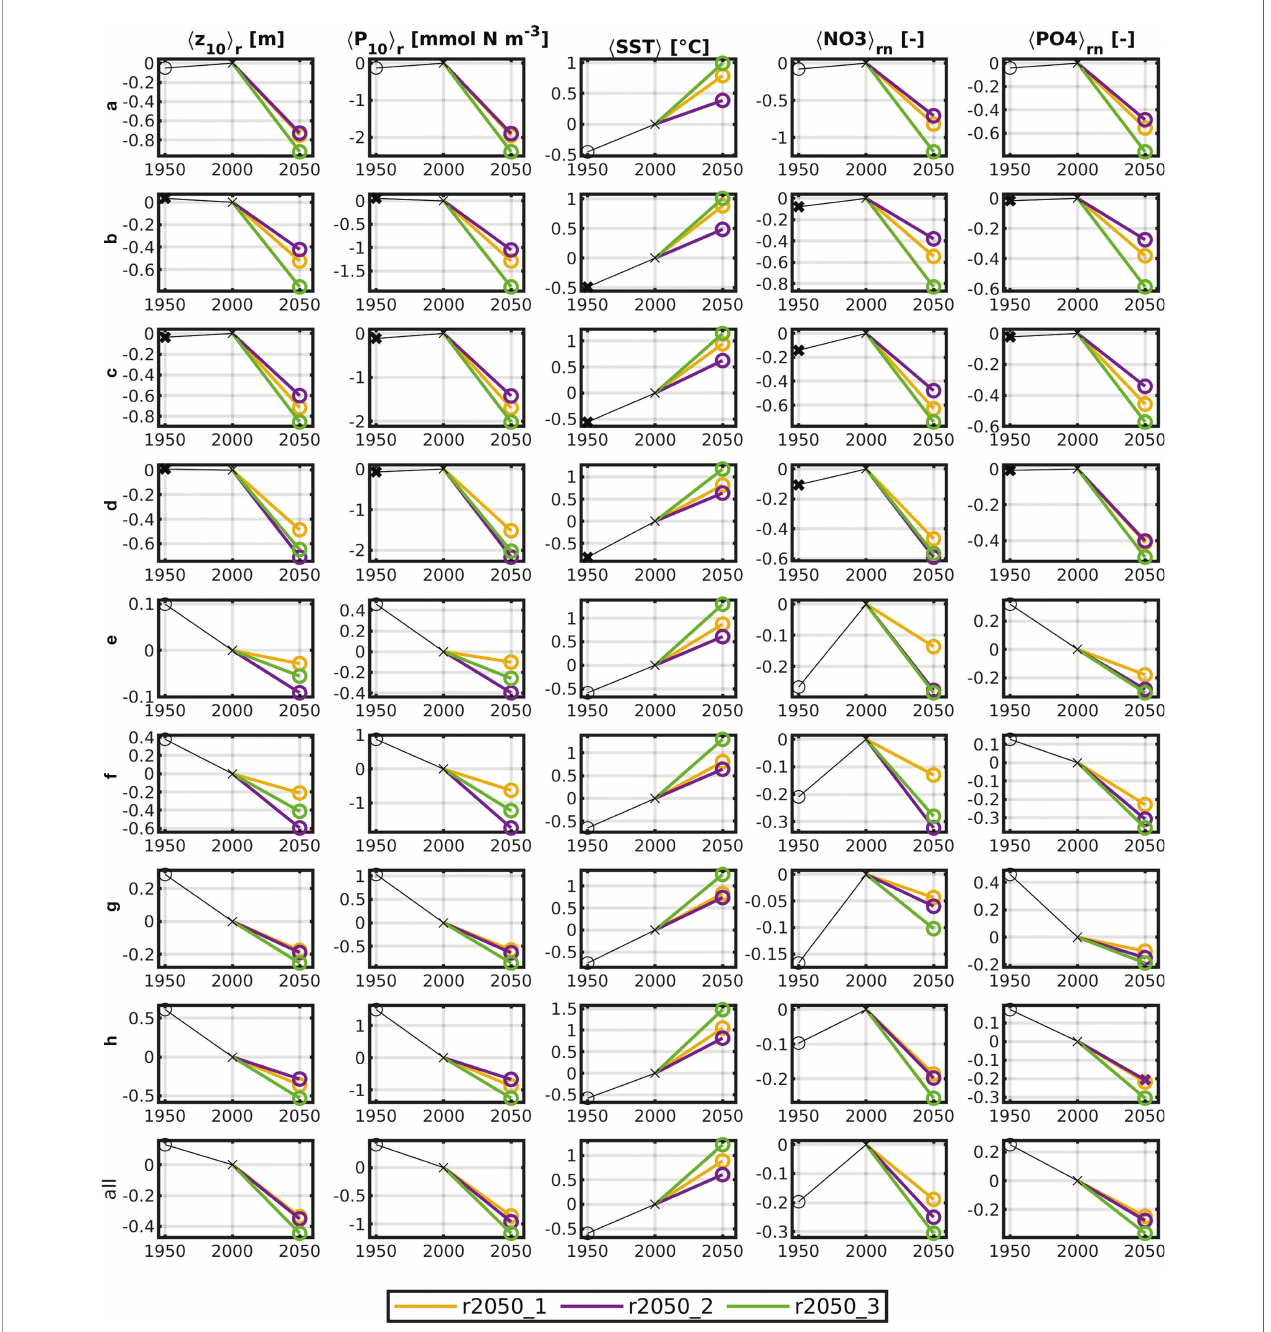
FIGURE 6 | Five-year means of < Z 10 > r , <P 10 > r , < SST > r , < NO 3> rn and < PO 4> rn . (column order) for all areas (row order) and all base runs. NO 3 and PO 4 are normalized by the respective 5-year means of r2000. The results of the t-test are marked with circles (signi fi cant change) and crosses (insigni fi cant change) for all runs except